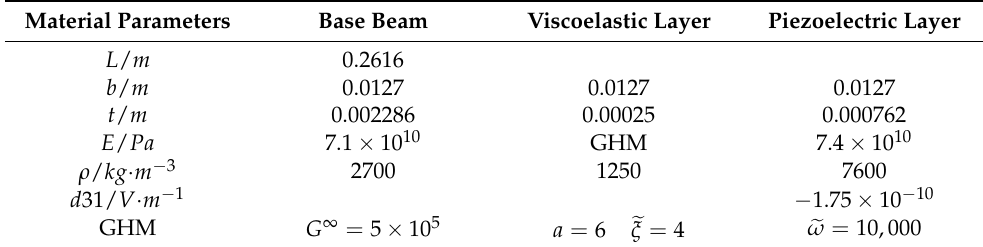
Table 1. Material parameters of ACLD cantilever beam.